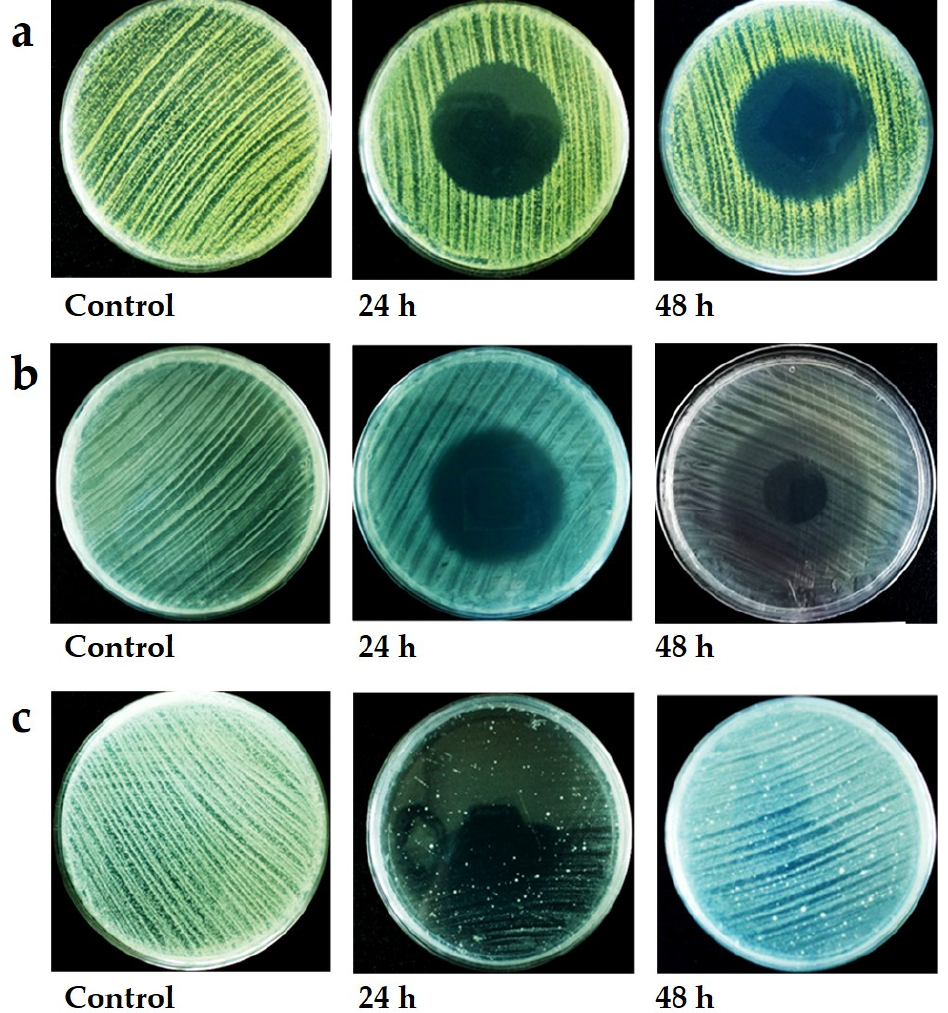
Figure 4. Appearance of bacterial cultures when exposed to selected volatile organic compounds. ( a ) M. luteus NCIB 8553 culture exposed to 10 µ L isovaleric acid. Note the dense growth at the edge of the inhibition zone. ( b ) E. coli NCIB 8277 culture exposed to 10 µ L isovaleric acid. Note the dense growth in the uninhibited zone and moderate growth in the recovery zone, with a clear zone at the centre where the concentration of the chemical was the highest. ( c ) B. subtilis NCIP 3610 culture exposed to 10 µ L cedrene. Note that the culture was mostly inhibited, except for a few colonies when exposed 24 h to this VOC, but total recovery occurred once the culture was ventilated and allowed to incubate for a further 24